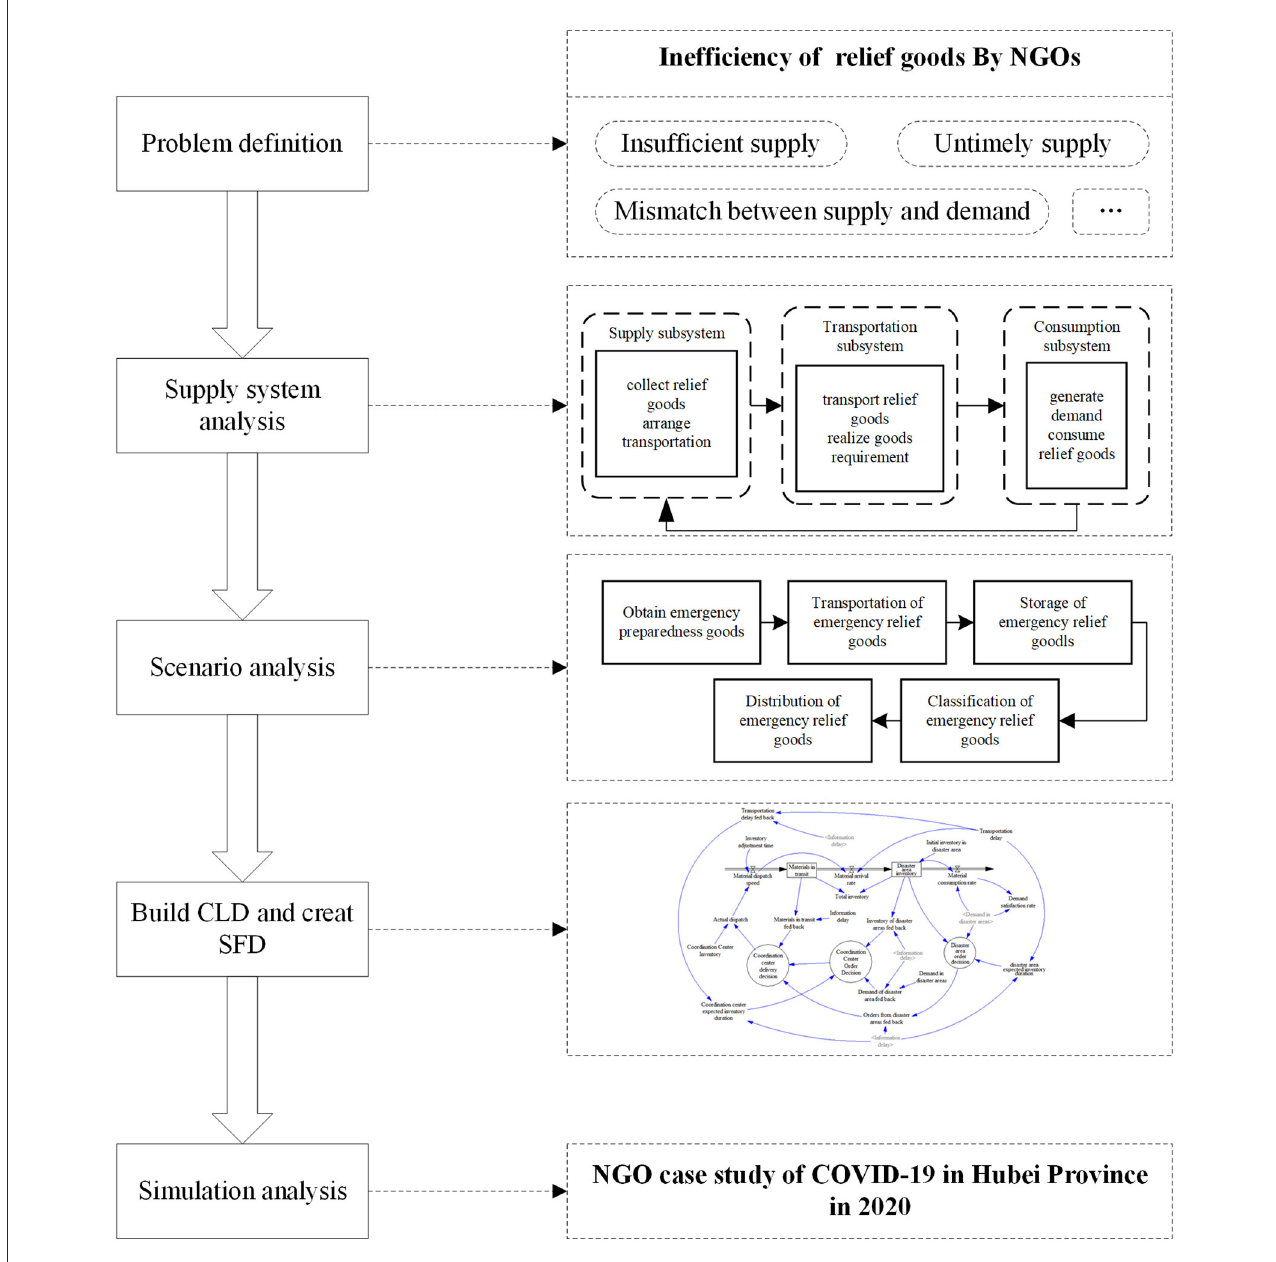
FIGURE1 Model development